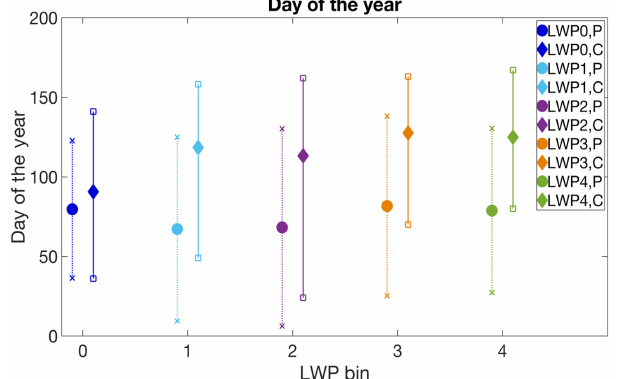
Figure 7. Mean day of sample for the distribution of sampled pro- file for clean and polluted clouds for each LWP scenario. Diamond markers with solid line indicate clean clouds; circle markers with dashed line represent polluted cases. The bars span the 20–80th per- centile of the day-of-year distribution for each